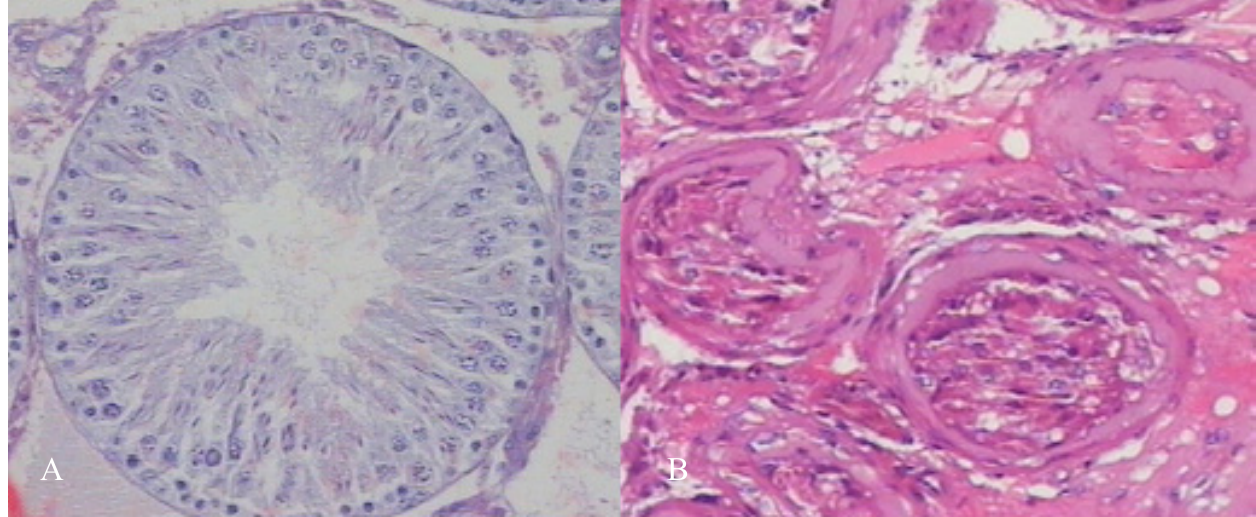
FIGURE 2 – Histologic appearance of the testes. A . Normal seminiferous tubule (H&E, X400). B . Necrotic tubules, with marked reduction in spermatogenesis, containing rare spermatogonia or only Sertoly cells, and thickening of the basement membrane (H&E, X170)